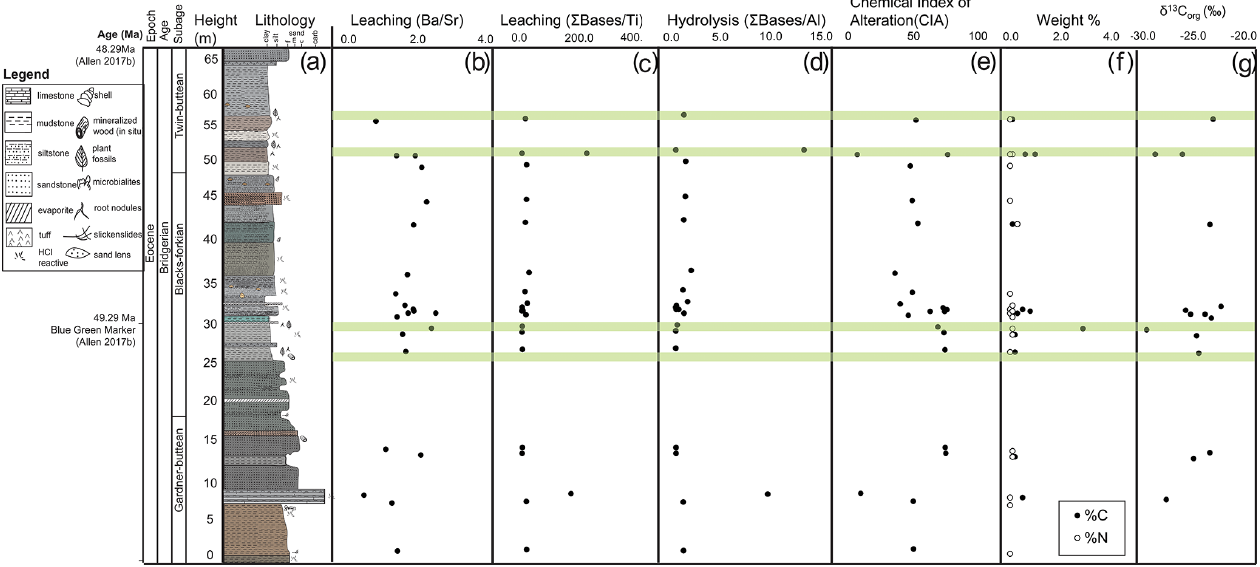
Figure 4. Stratigraphy with sedimentary geochemistry. (a) Stratigraphic column at the Blue Rim escarpment of the Bridger Formation. Geochemistry including (b) leaching calculated using molar ratios of Ba / Sr, (c) leaching calculated using the ratio of the sum of bases to titanium, (d) hydrolysis calculated using the ratio of the sum of bases to aluminum, (e) the Chemical Index of Alteration to measure weathering (Eq. 1), (f) weight %C (black circles) and %N (white circles), and (g) δ 13 C org values. Light green transparent areas show stratigraphic levels containing plant